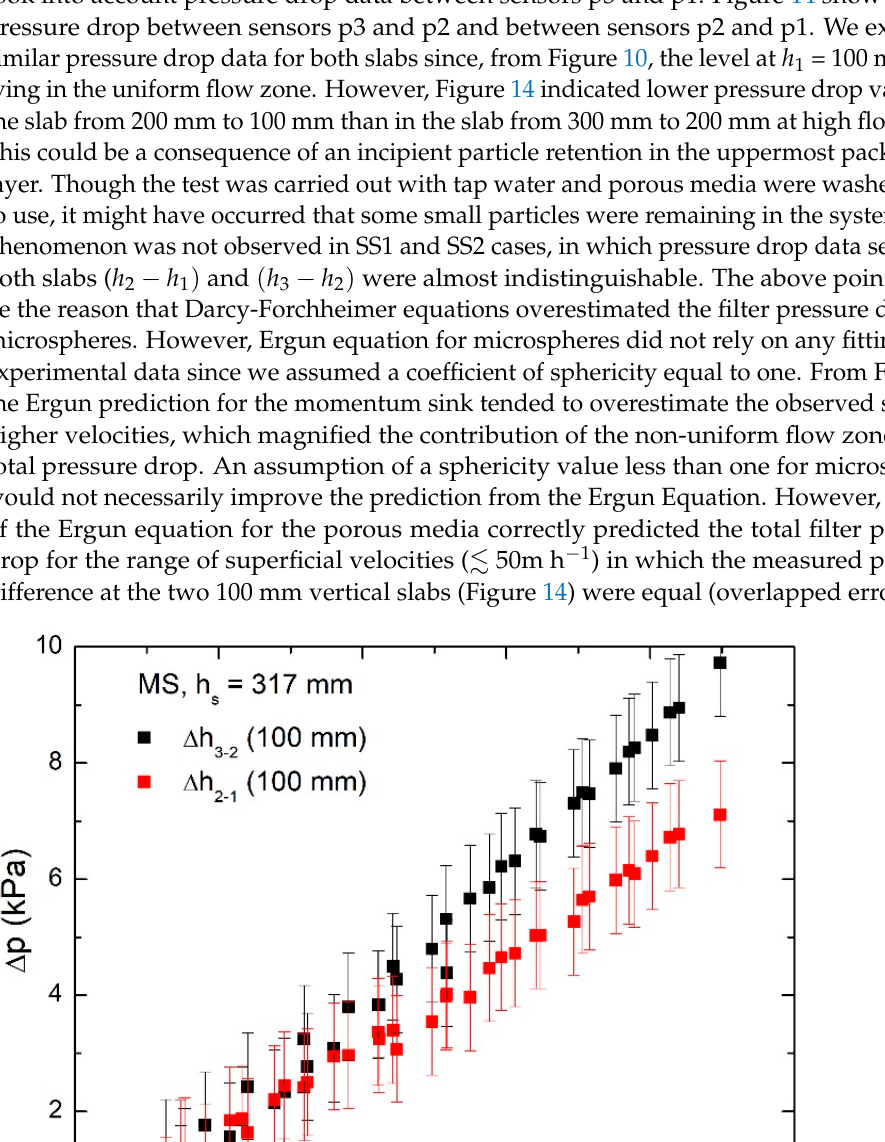
= 300 (cid:2871) = 200 mm and ℎ = 100 mm (cid:2870) (cid:2869)